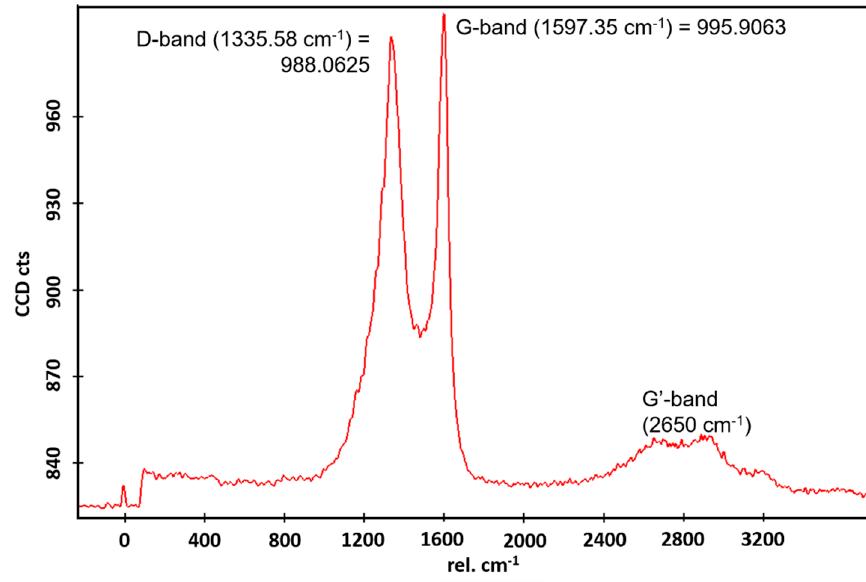
Figure 8. Raman spectra of CNT monolith.